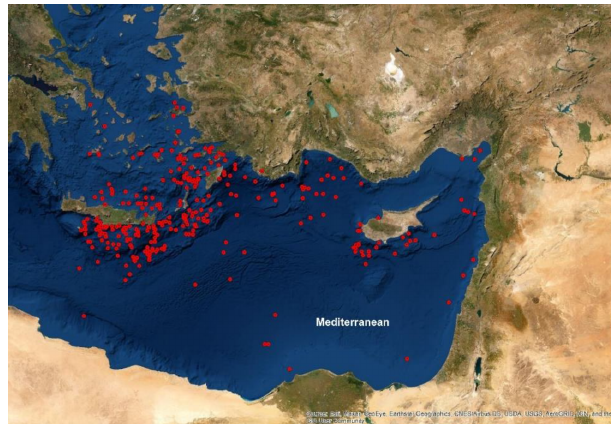
Figure 6. Historical earthquake locations that are used as the epicenters of the hypothetical earthquakes (sources: Esri, Maxar, GeoEye, Earthstar Geographics, CNES/Airbus DS, USDA, USGS, AeroGRID, IGN, and the GIS User